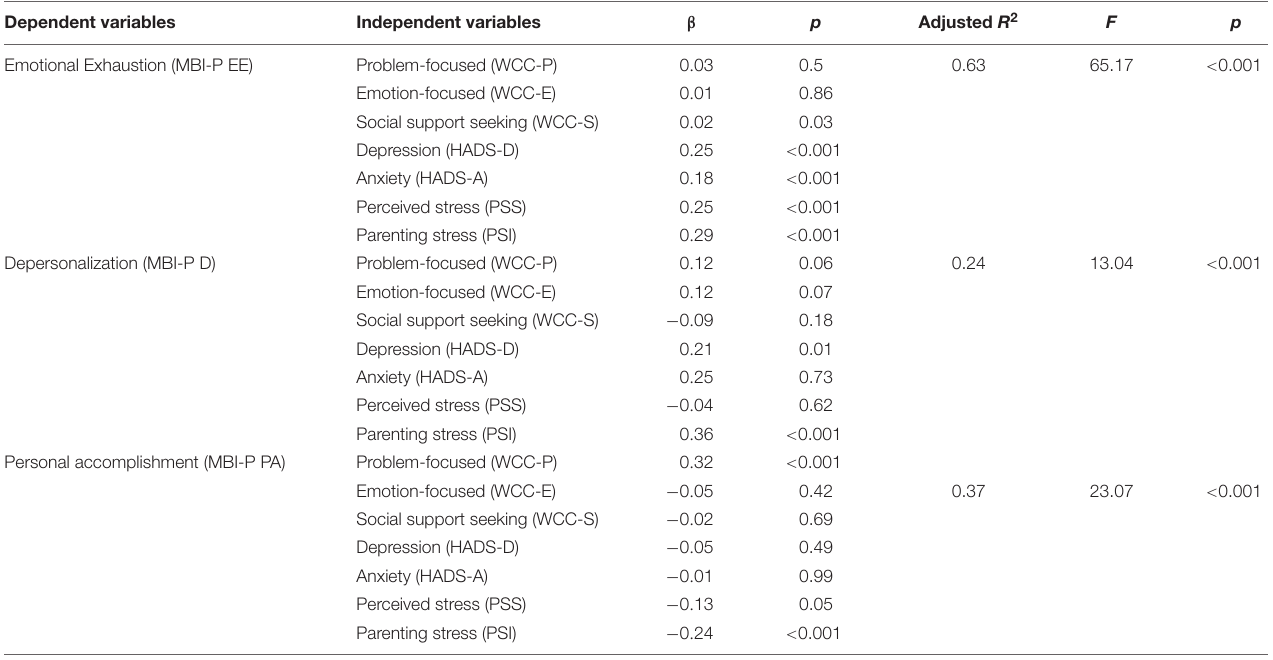
TABLE 3 | Multivariate linear regressions with psychological variables predicting maternal burnout scores (MBI-P). Dependent